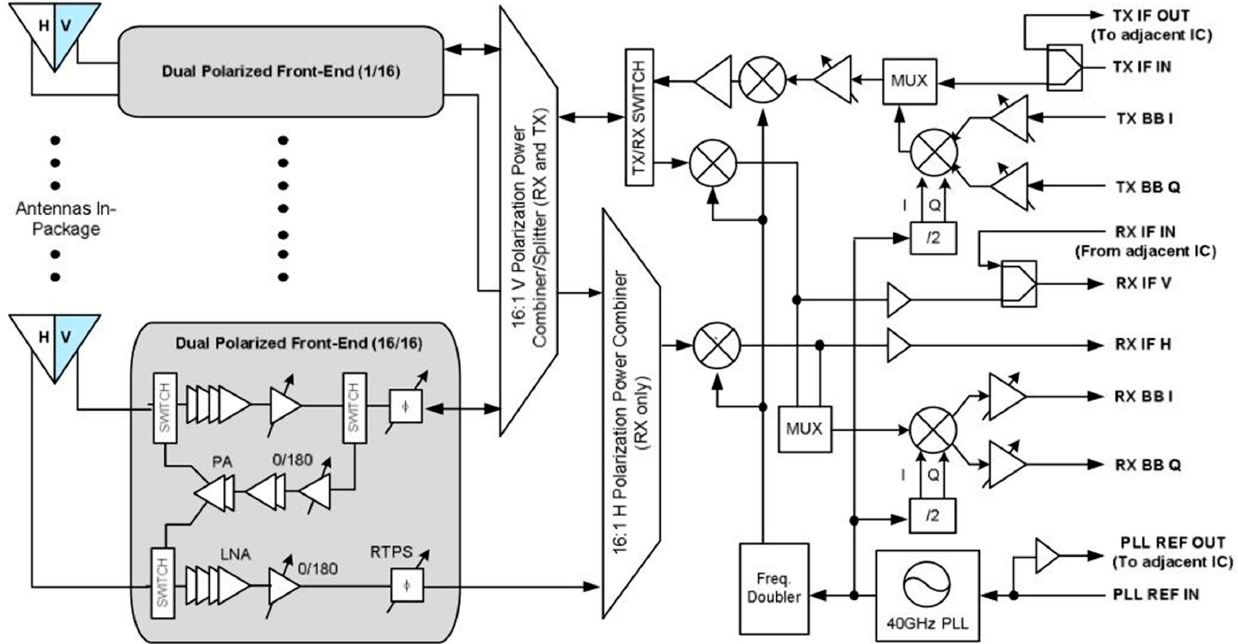
Figure 19. The system block diagram of the dual-polarization W-band phased array transceiver